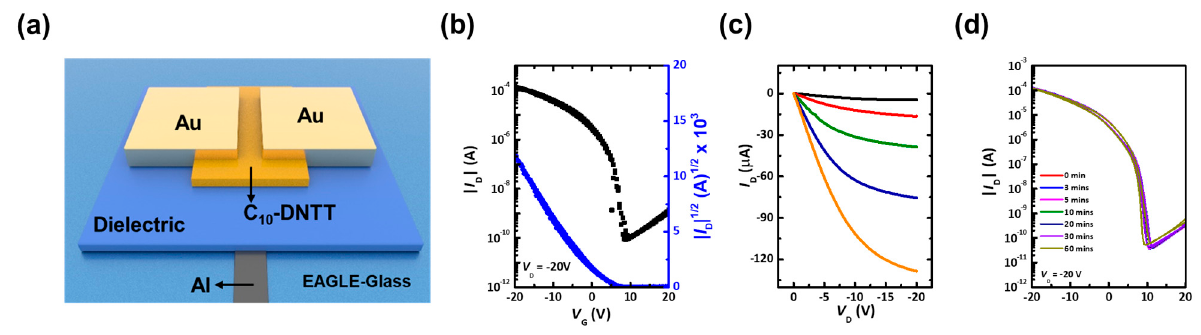
Figure 4. ( a ) Schematic illustration of OFET device and electrical properties: ( b ) transfer, ( c ) output, and ( d ) transfer curve with bias stress test.